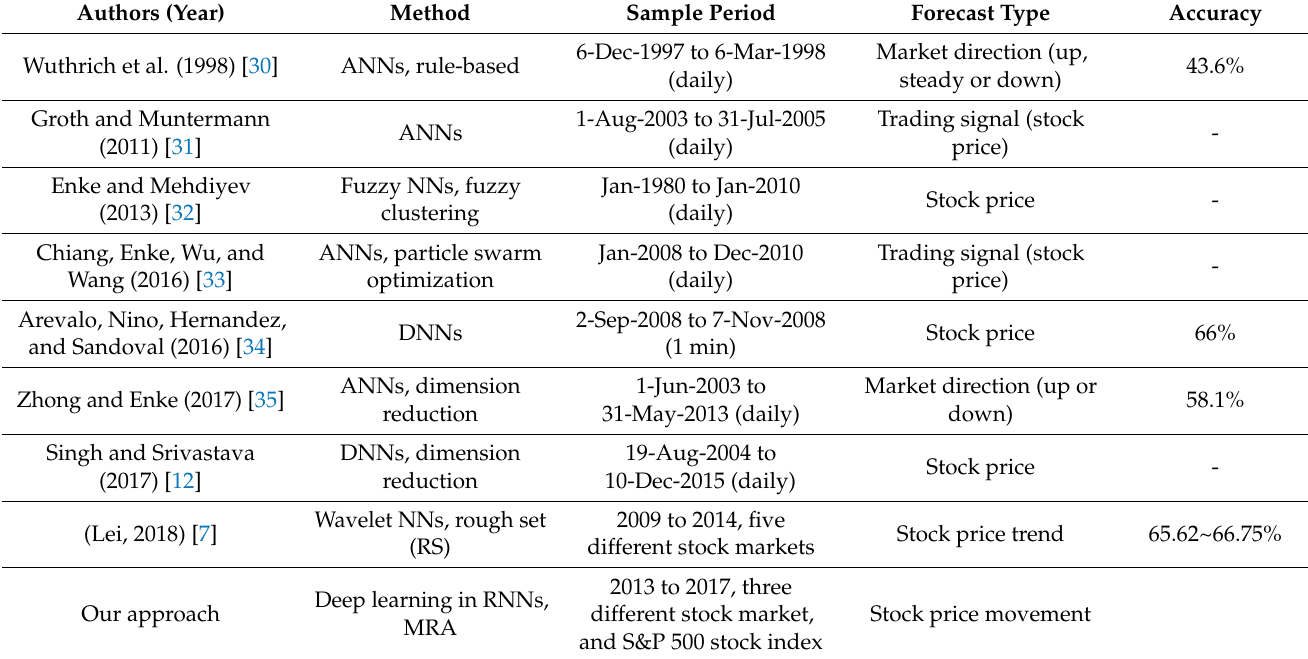
Table 1. Research relates to stock price prediction using neural networks.